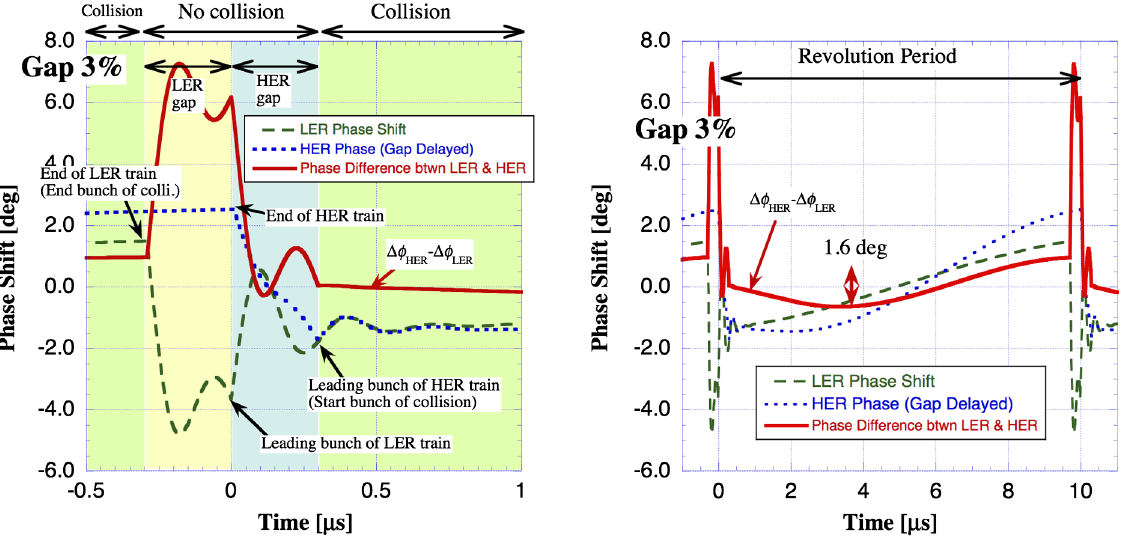
FIG. 14. Phase difference for a 3% gap with HER gap delay. The phase difference at the leading part of the train is almost canceled, while the phase difference of the other part in the train increased to 1.6